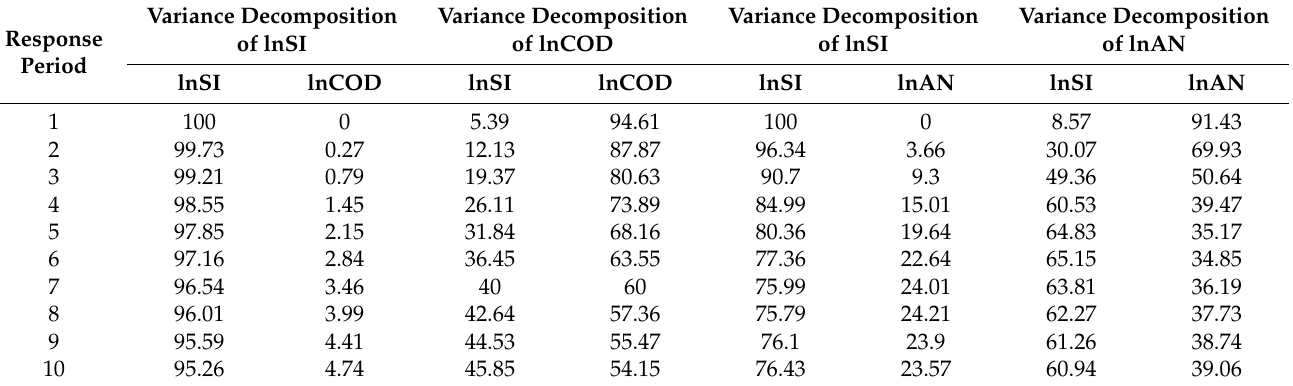
Table 8. Forecast variance decomposition of the discharge of pollutants to the aquatic environment in response to industrial structure adjustment in Xinjiang.